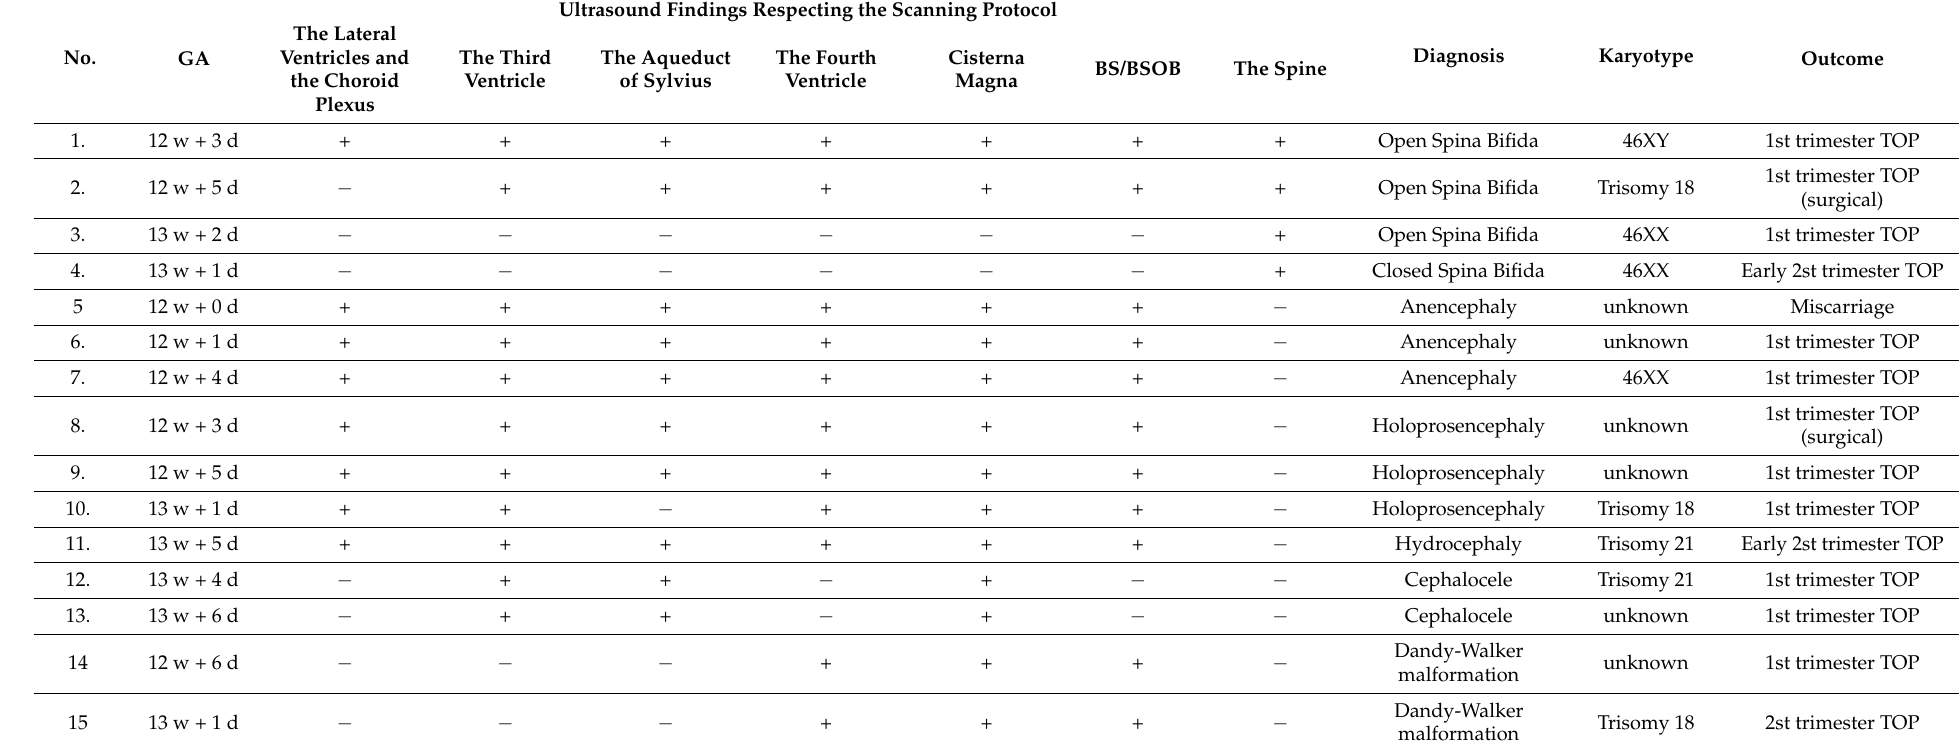
Table 2. Abnormal US features, karyotype and outcome of cases with FT CNS